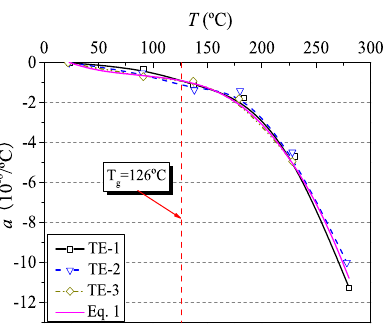
Figure 5. Expansion coefficient–temperature curves.